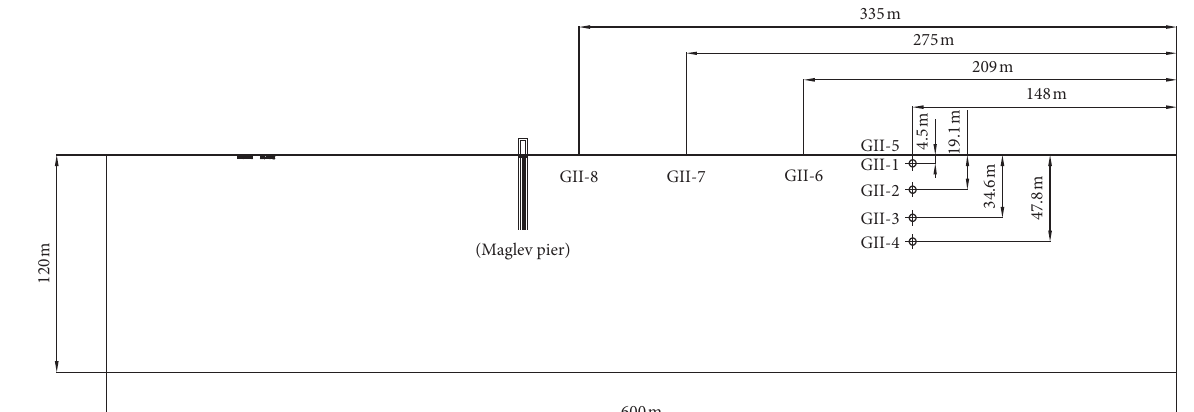
Figure 2: Layout of monitoring points in the second group of field measurements.